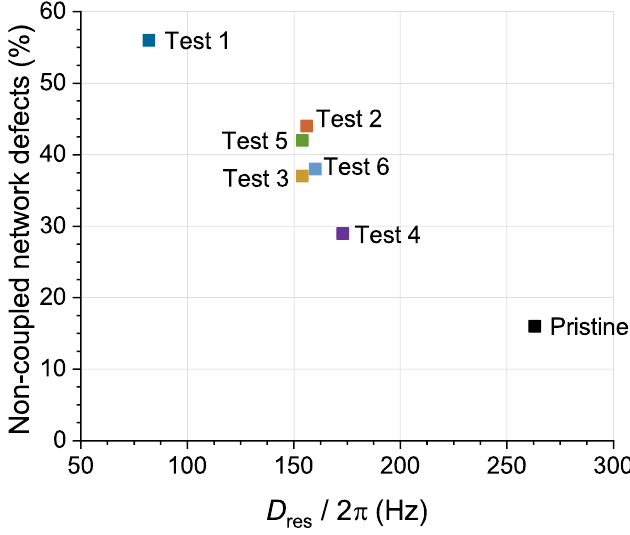
Figure 12. Evolution of the noncoupled defect fraction as a function of the average residual dipolar coupling (proportional to the density of constraints in the rubber matrix) for pristine GTR and microwave-assisted devulcanized GTR samples.